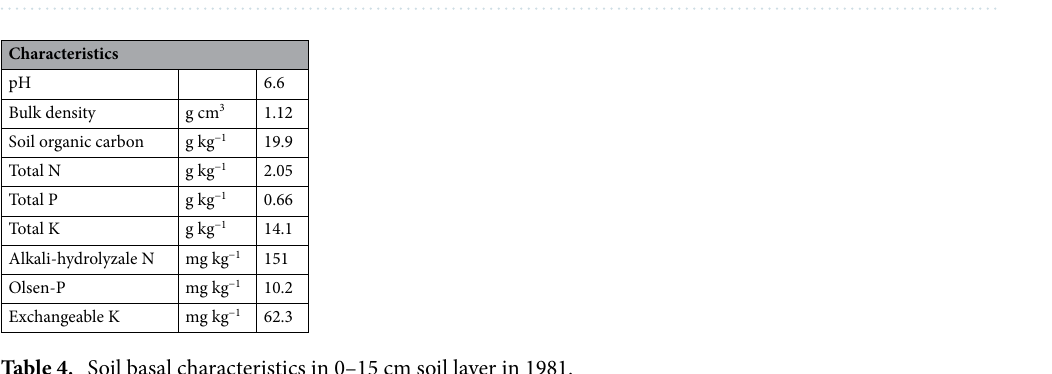
Figure 7. Total precipitation from April to October in each year (A), monthly precipitation ( B ), and monthly mean temperature from April to October in the years from 1981 to 2015 ( C ). Red lines indicate the mean value.